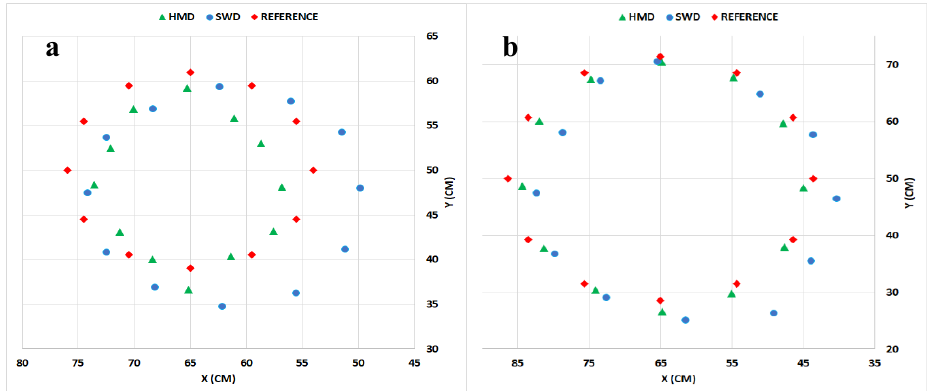
Figure 9. Average positions judgment with respect to reference target at a target distance of 65 cm from the participants for the exocentric distances ( a ) D1 and ( b ) D2 that compared HMD and SWD.